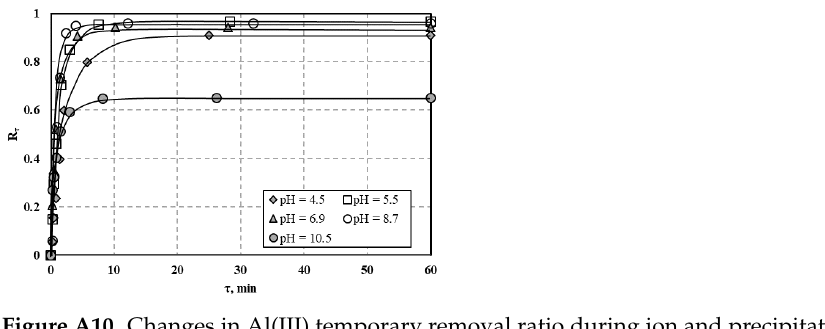
Figure A10. Changes in Al(III) temporary removal ratio during ion and precipitate flotation from solution containing Al(III), Cu(II), and Zn(II) mixture—effect of pH (c 0 = 2 mmol dm − 3 , c SDS = 0.187, u G = 1.51 mm s − 1 ).